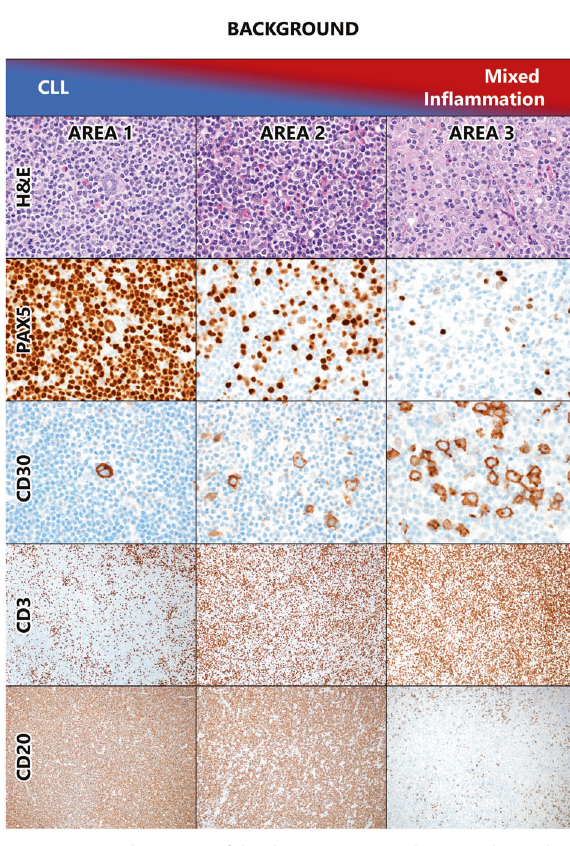
Fig. 2 Case with areas of both CLL-HRS and CHL. The columns show three areas from a single lymph node in which areas of clear CLL-HRS (Area 1) and CLL-HL (Area 3) are present, along with intermediate areas in which the background is a mixture of CLL and in fl ammatory cells (Area 2). We hypothesize that CLL-HRS and CLL- HL exists on a biologic spectrum wherein HRS cells exist fi rst in a cellular milieu composed of predominantly CLL cells (shown in blue in the top bar) and progress through stages where progressively more in fl ammatory cells (T cells, histiocytes, granulocytes, plasma cells) are recruited (shown in red in the top bar). In isolation, Area 2 would be diagnostic of CHL, while Area 1 would be diagnostic of CLL-HRS. Magni fi cation: HE, PAX5, CD30 all 600x oil; CD3 and CD20